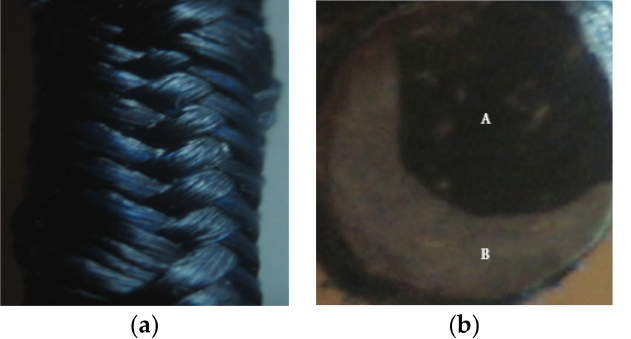
Figure 23. ( a ) Surface texture of BCR; ( b ) Cross-section of distributed carbon fiber: A—carbon fiber; B—matrix. Reproduced with permission from [85], Hindawi,